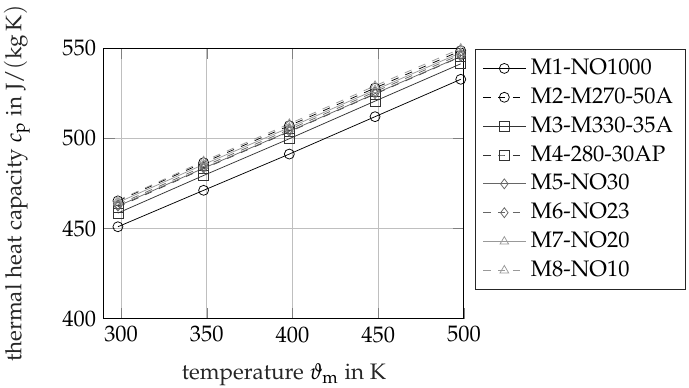
Figure 8. Results of the calculation of the thermal heat capacity c p ( ϑ )